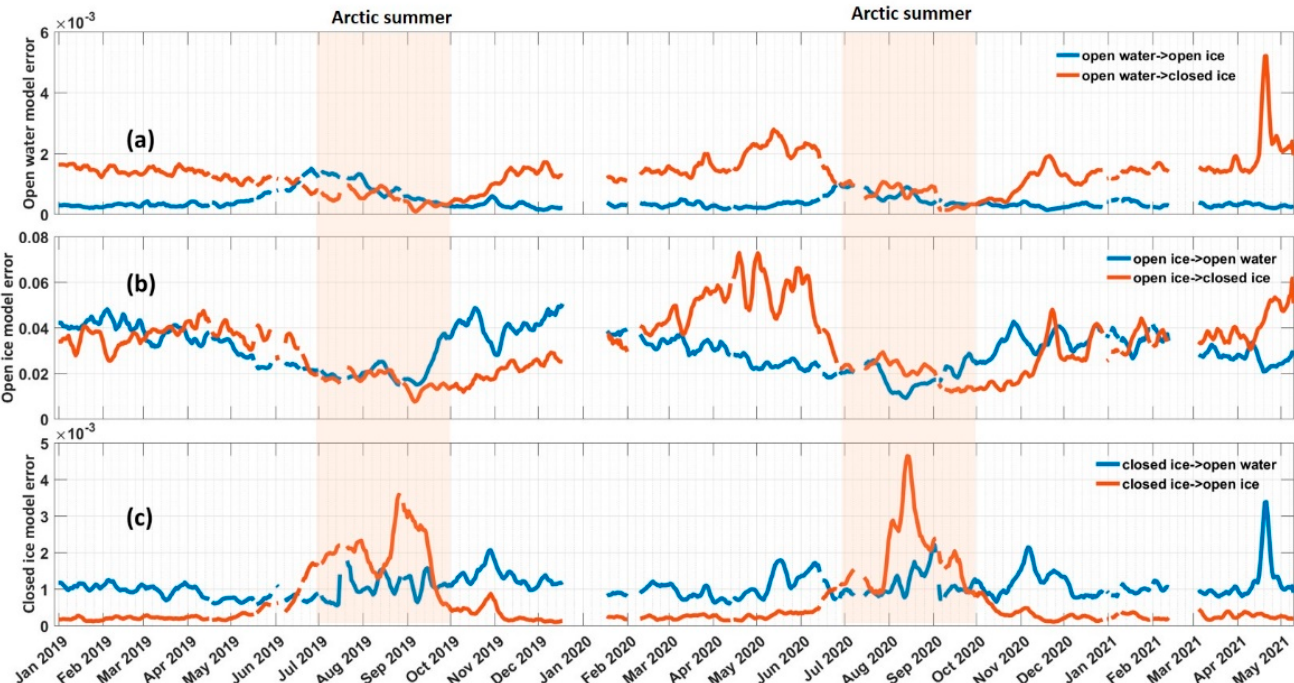
Figure 10. The error analysis of the Arctic sea ice monitoring training models from 1 January 2019 through 10 May 2021: ( a ) open water is misclassified as open ice (blue line) and closed ice (red line), respectively, ( b ) open ice is misclassified as open water (blue line) and closed ice (red line), respectively, and ( c ) closed ice is misclassified as open water (blue line) and open ice (red line), respectively.